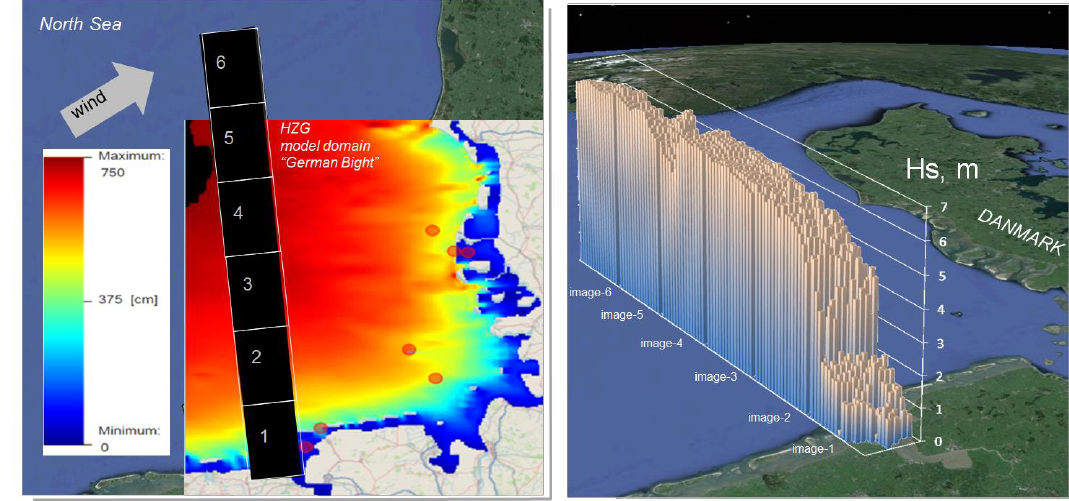
Figure 13. An example of an acquisition of a storm on 10.12.2014 at 17:19 UTC. Sequences of 6 TerraSAR-X StripMap images across North Sea with results of HZG wave model “German Bight” as background (source: COSYNA) (left) and 3-D significant wave height on © Google Earth extracted from TS-X images using XWAVE algorithm